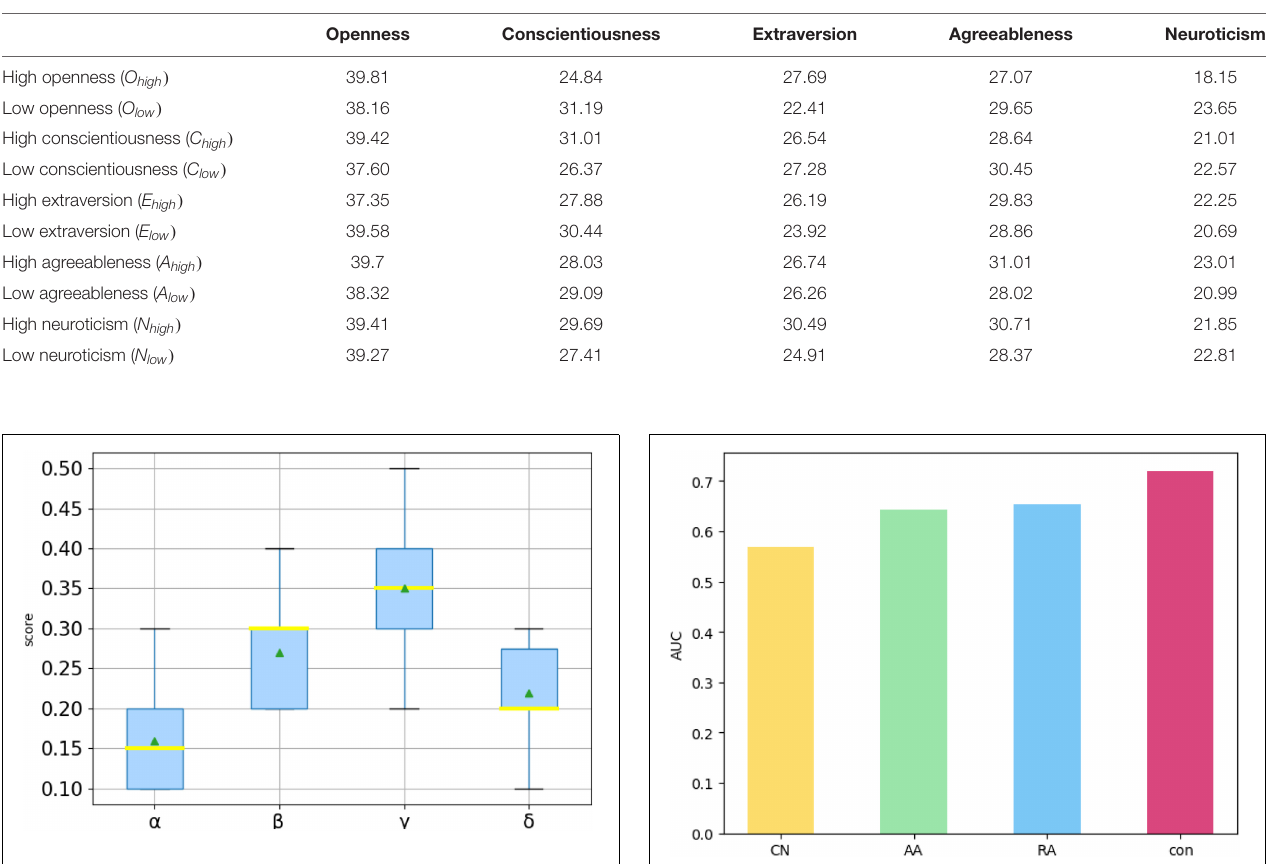
FIGURE 9 | Distribution of optimal weights.